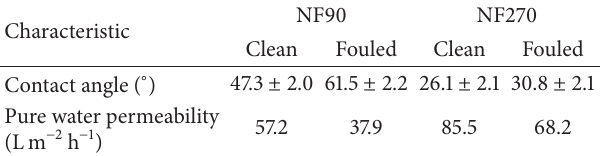
Table 2: Comparison of clean and fouled membrane properties. NF90 NF270 Characteristic Clean Fouled Clean Fouled Contact angle ( ∘ )